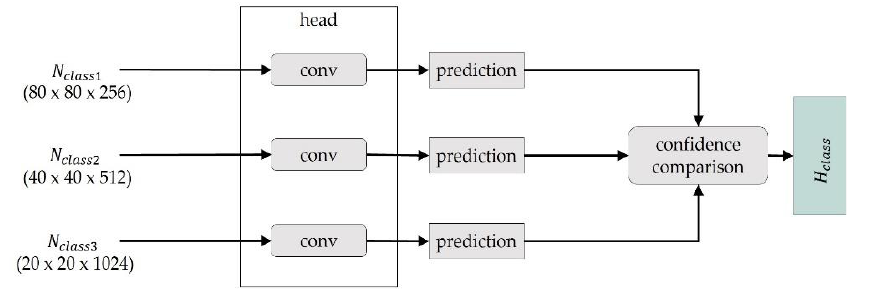
Figure 5. Head module of OASIS-Net.